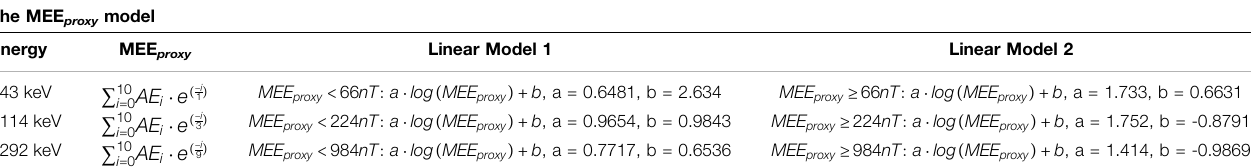
TABLE 2 | The MEE proxy models for two separate MEE proxy intervals. The models give the logarithmic value of > 43, > 114, and > 292 keV loss cone fl uxes over the 55 ° – 70 ° CGM latitude band. The MEE proxy model Energy MEE proxy Linear Model 1 Linear Model 2